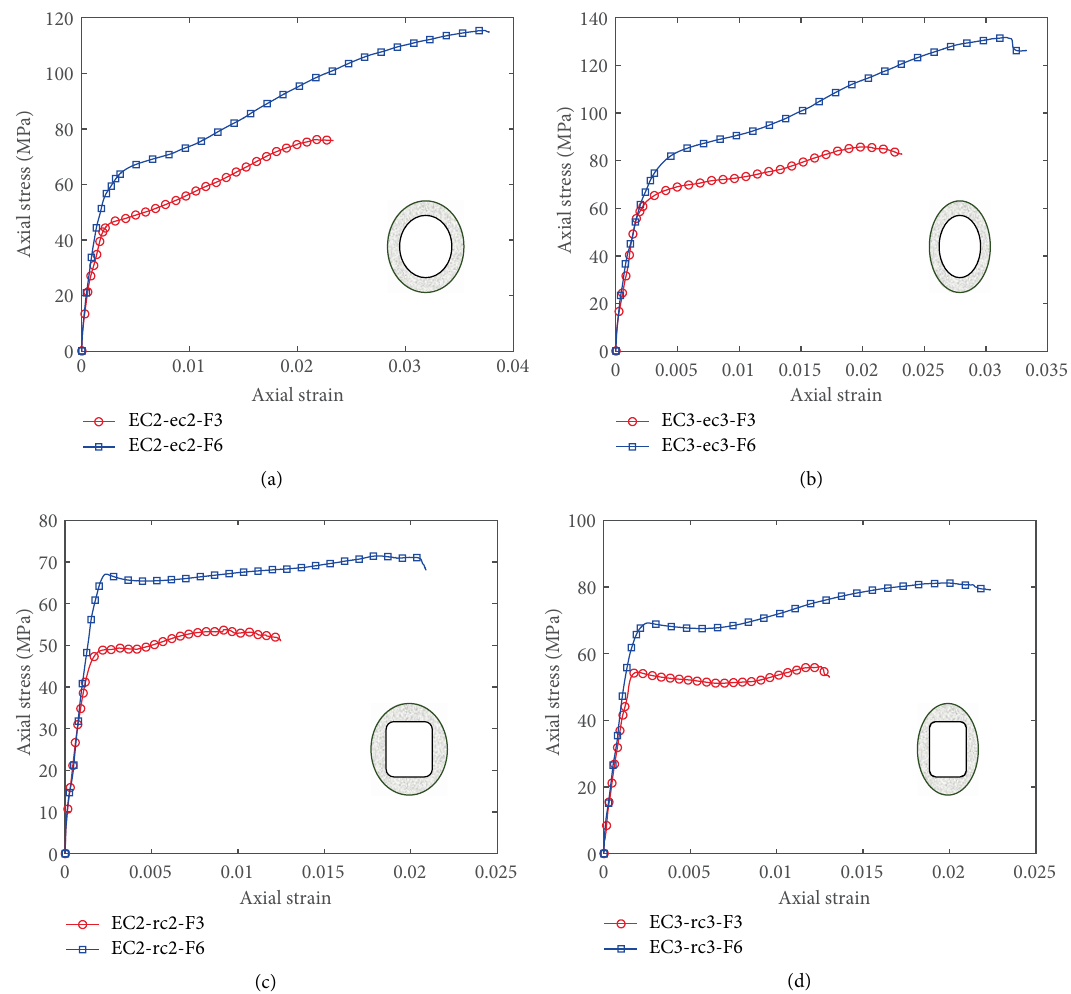
Figure 11: Effect of FRP thickness. (a) EE-DSTCs,